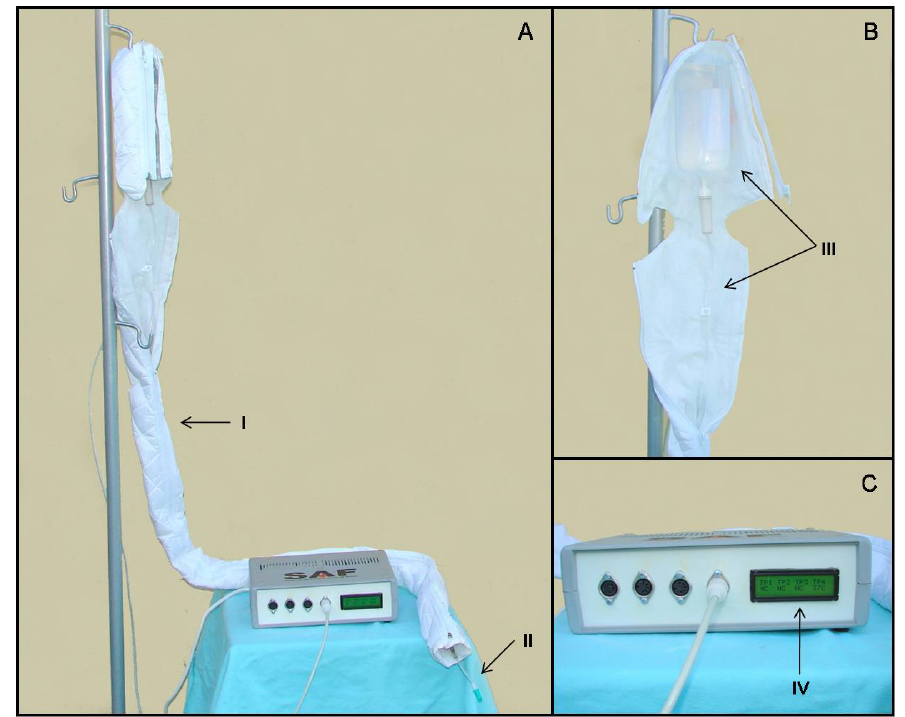
FIGURE 1 – Illustrative representation of Fluid Heating System (SAF ® ). In A , set demonstrating the heating pad around the infusion tube ( I ) and its connection to venopuncture site ( II ); In B , zoom image of heating pad indicating ( III ) the sites of resistors; In C , central command unit, and visual display, showing the temperature of the fluid to be infused ( IV